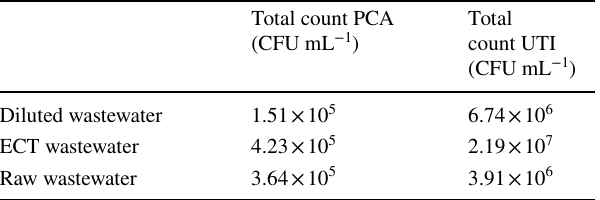
Table 1 Concentrations of colony-forming units (CFU) found in the investigated wastewater streams